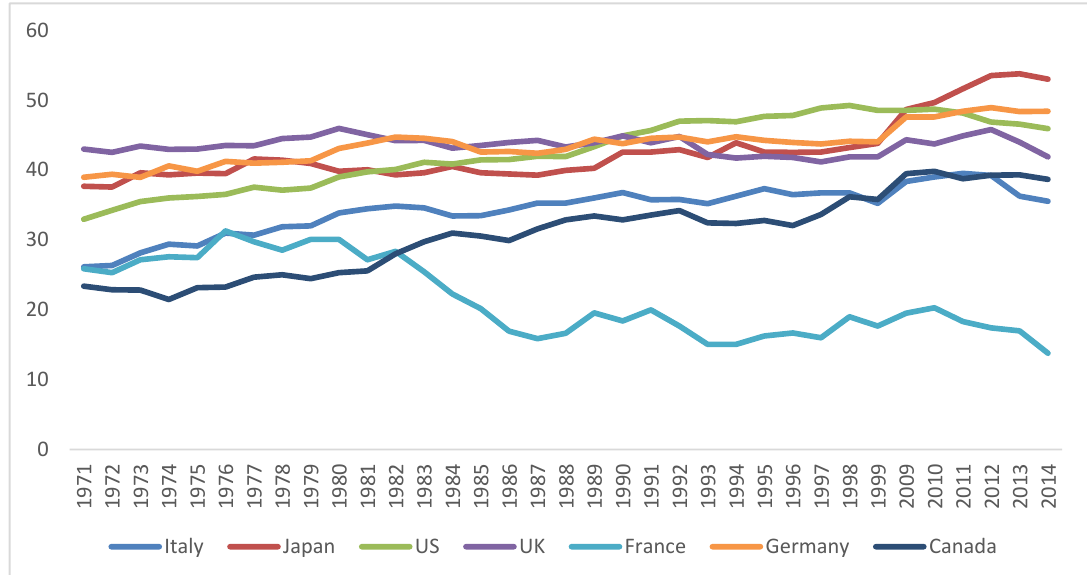
Figure 1. The Trend of CO 2 emissions from the production of electricity and heat as a whole (% of total fuel burned) for G7 countries from 1971 to